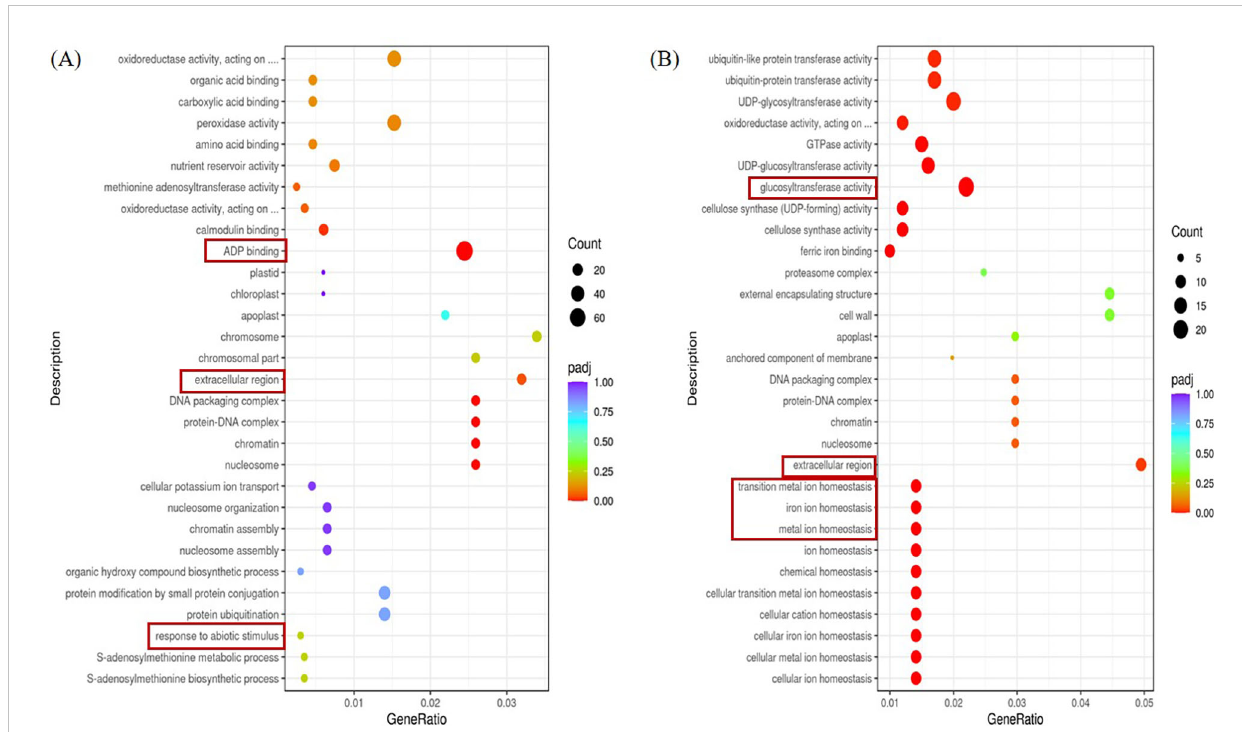
FIGURE 6 GO terms for the top 20 signi fi cant DEGs. (A) The fi rst 20 GO terms in the root parts were signi fi cantly enriched at the P<0.05 level in the comparison between CK and salt stress treatments. (B) The fi rst 20 GO terms in the leaf parts were signi fi cantly enriched at the P<0.05 level in the comparison between CK and salt stress treatments.